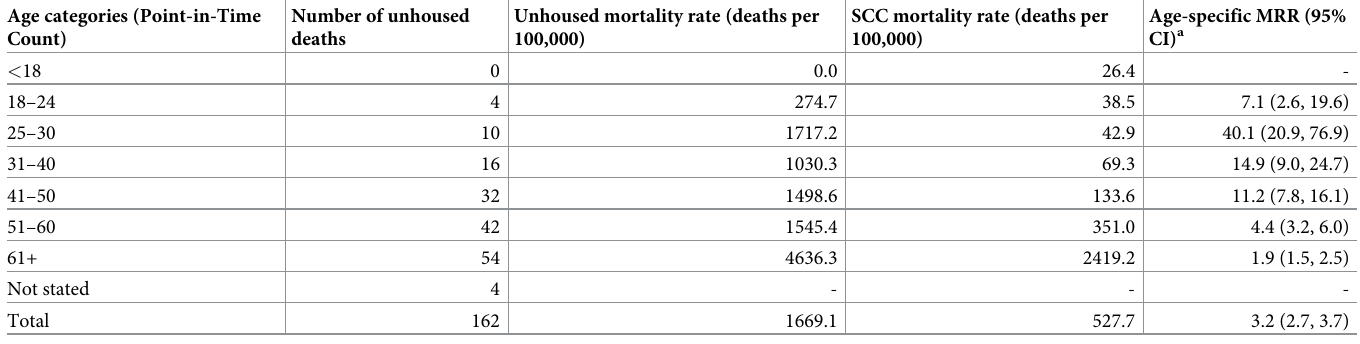
Table 3. Age-specific mortality rates for the Santa Clara County (SCC) unhoused population and the SCC general population (n = 974 deaths; 88,658 deaths respec- tively) and age-specific mortality rate ratios in 2019. Age categories (Point-in-Time